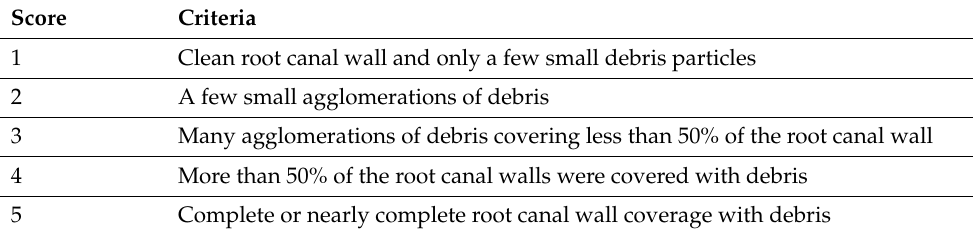
Table 2. Scoring criteria for smear layer